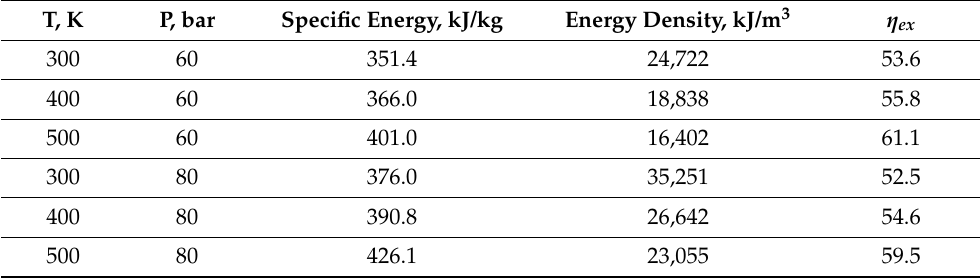
Table 3. Exergy of compressed air at different conditions and exergetic efficiency of the two-stage compression